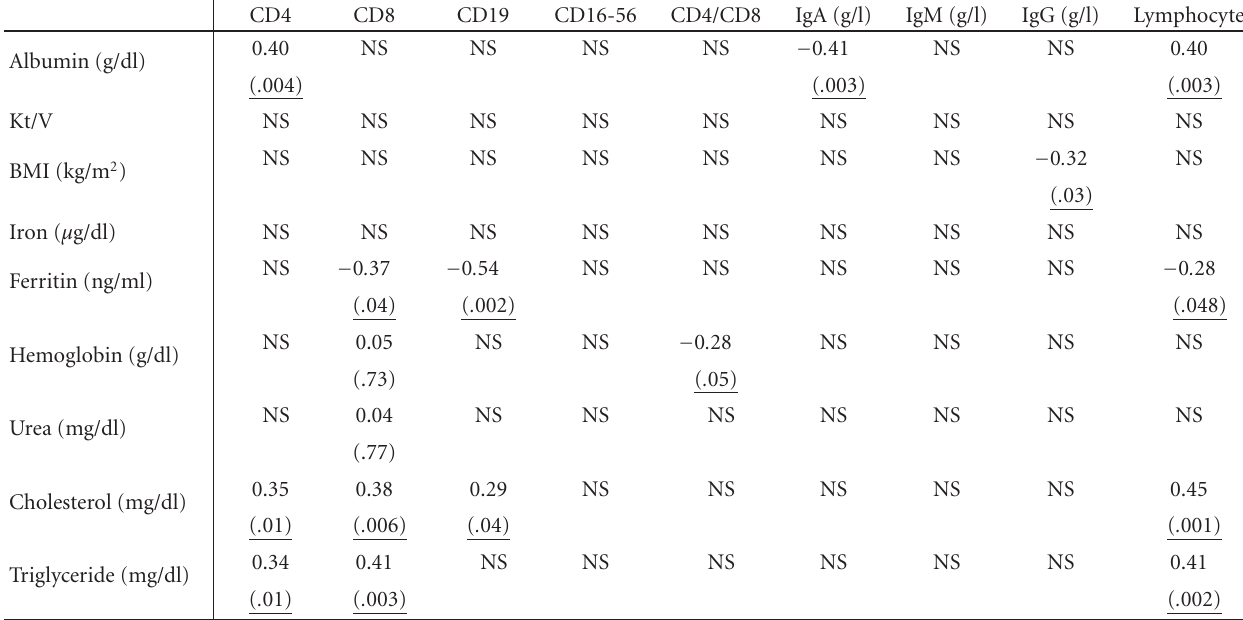
Table 2: Correlation between some nutritional or certain parameters and immune parameters. Upper values are Pearson’s correlation coef- ficients; the belows are r and P values (NS: not